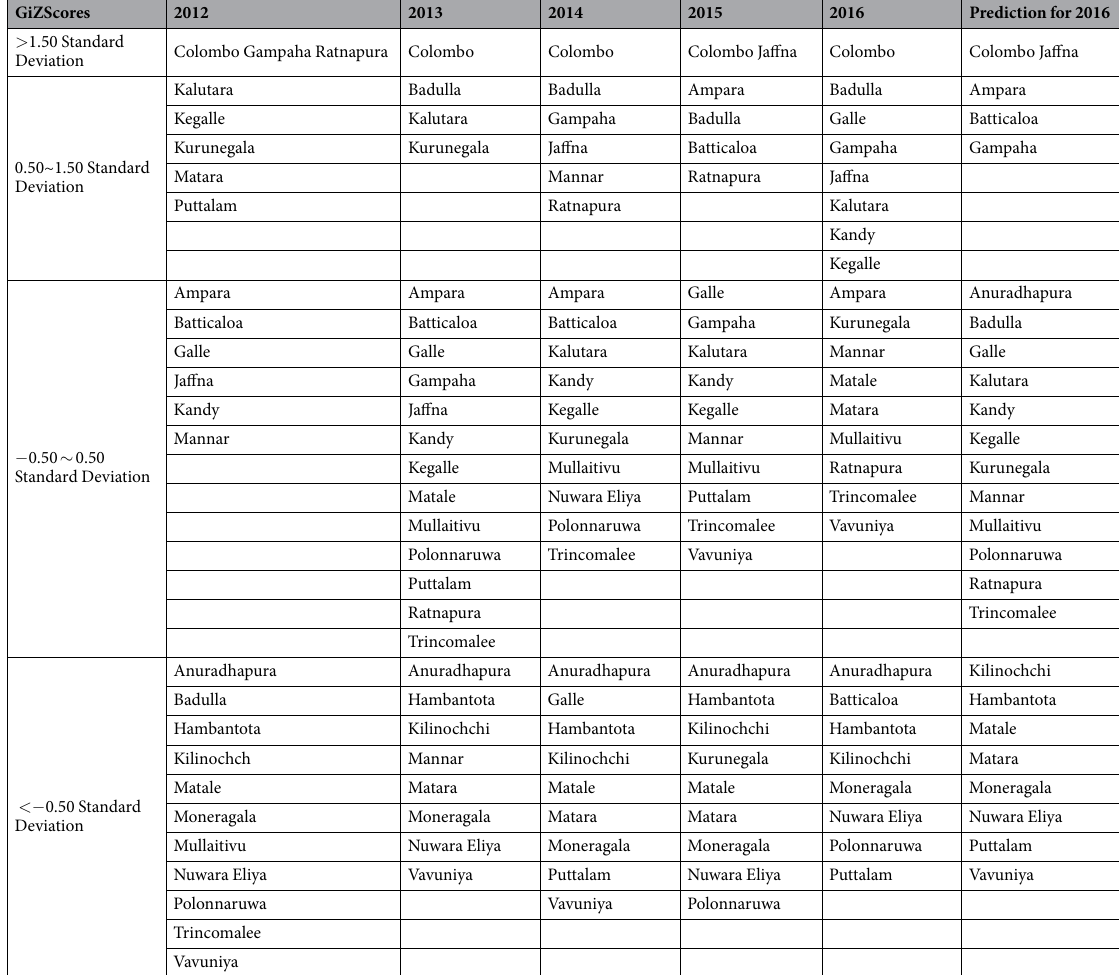
Table 3. Results of hot spots analysis on dengue incidences, Sri Lanka in 2012–2016. Hot and cold spots were identified according to dengue incidences and climatic factors in Sri Lanka from 2012 to 2016. Getis–OrdG i * statistic was used to detect hot spots of dengue epidemic in Sri Lanka from 2012 to 2016. High GiZscores are associated with hot spots, and low GiZscores are associated with cold spots. Hot spots were mainly located in west coast of Sri Lanka near Colombo. The hot spots tended to shift eastward to the east coast of Sri Lanka, and northward to Jaffna. Cold spots were mainly distributed in the southern area surrounding the Moneragala district, and the mid-northern area adjacent to the Anuradhapura district. The last column is prediction for hot spots and cold spots of 2016 with the predicted dengue incidences in Fig. 1 for 2016.